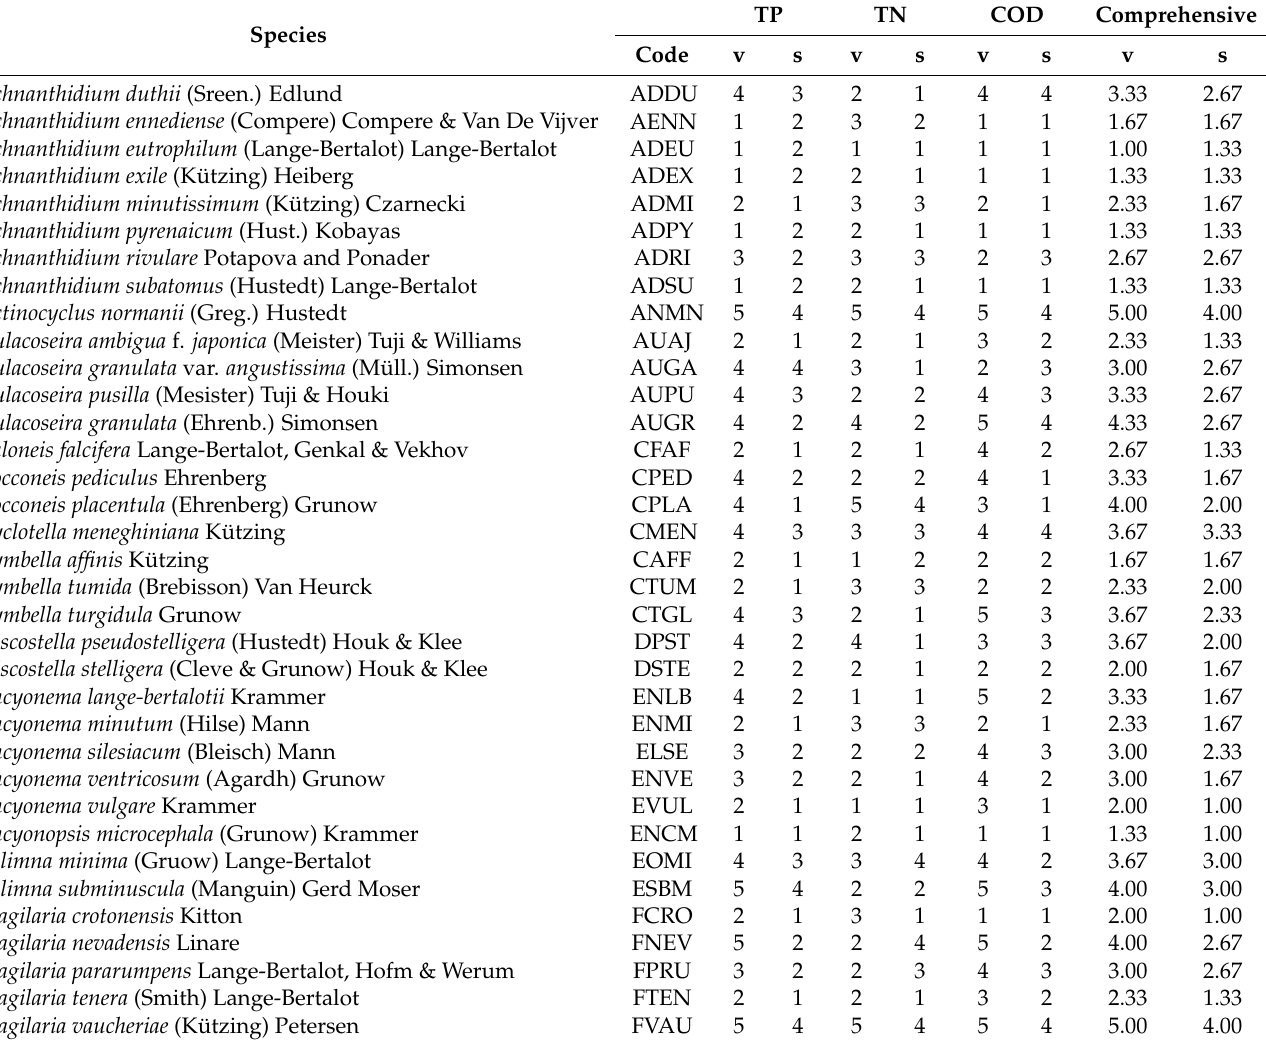
Table 1. List of TP, TN, COD, and comprehensive indicators (indicator (v) and sensitivity (s) values) of the periphytic diatoms. Species